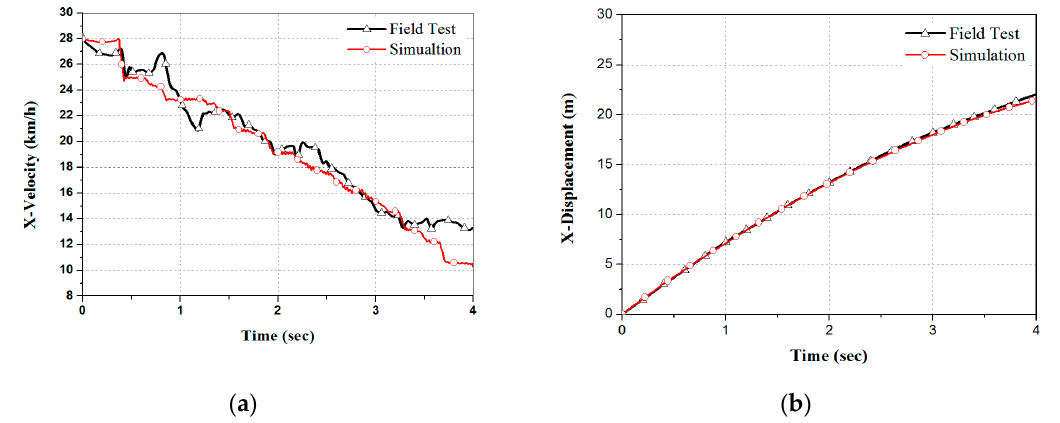
Figure 12. The comparison of results between the field test and the simulation. ( a ) X-Velocity Figure12. Thecomparisonofresultsbetweenthefieldtestandthesimulation. ( a )X-Velocity(Longitudinal); (Longitudinal); (b) X- Displacement (Longitudinal). ( b ) X-Displacement